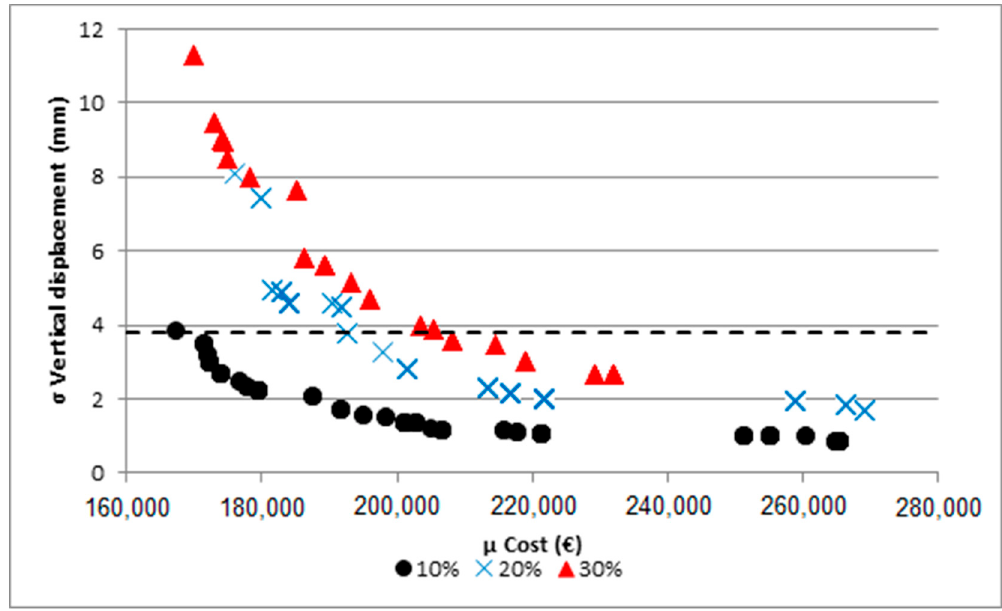
Figure 4. Pareto frontier of modulus of elasticity Robust Design Optimization (RDO) problems.